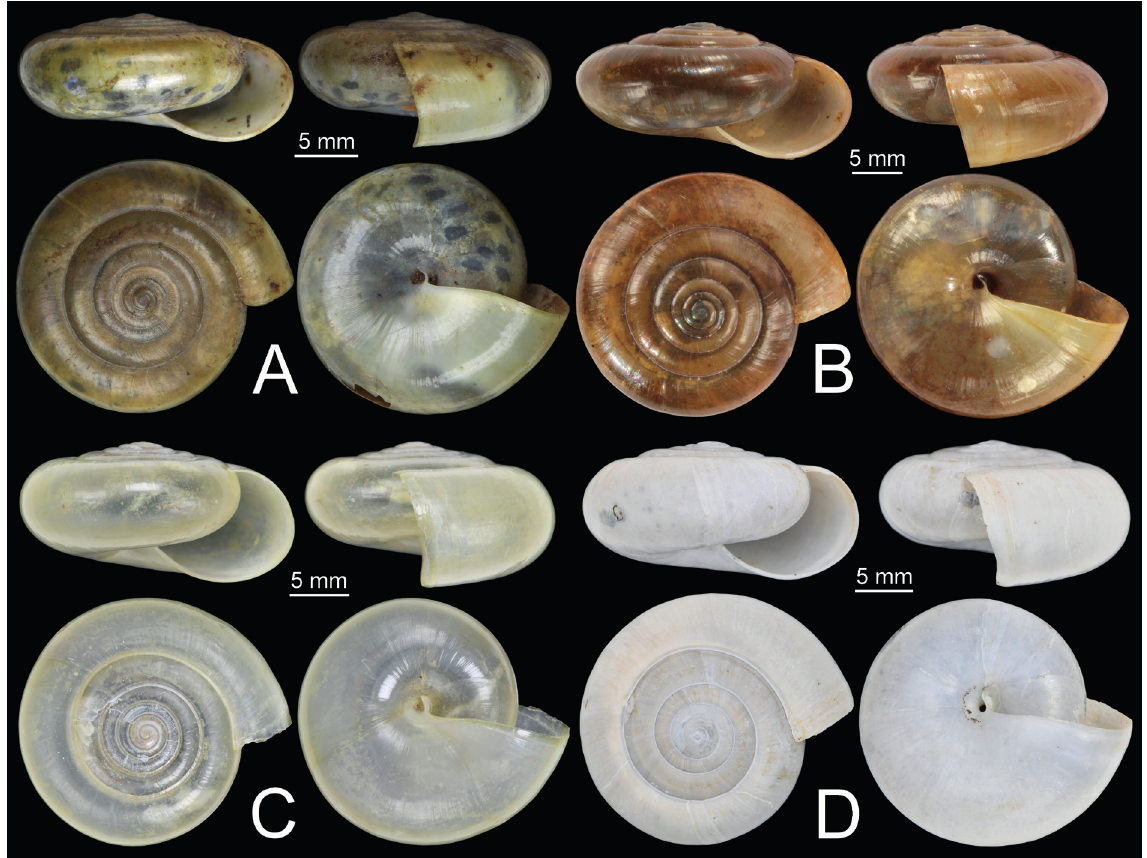
Fig. 2. Shells of Sarika spp. A . Sarika resplendens (Philippi, 1846) (NHMUK 1903.7.1.112). B . S. bocourti (Morelet, 1875) (CUMZ 7900). C . S. lactoconcha Pholyotha & Panha sp. nov., holotype (CUMZ 7901). D . S. lactoconcha Pholyotha & Panha sp. nov., paratype (CUMZ